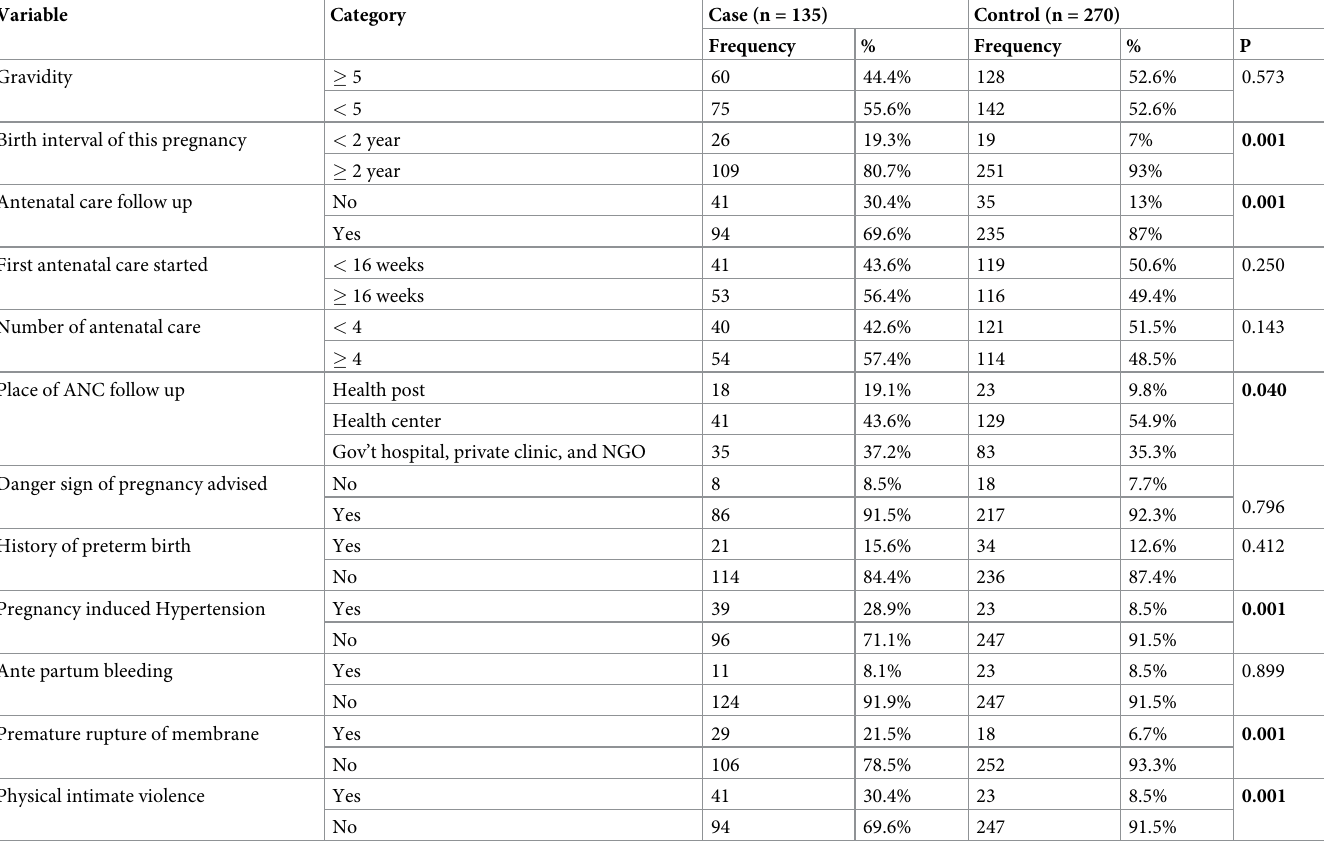
Table 2. Obstetrics and social related characteristics of mothers who gave birth at public hospitals in Sidama region, Southeast Ethiopia, 2020 (n = 405). Variable